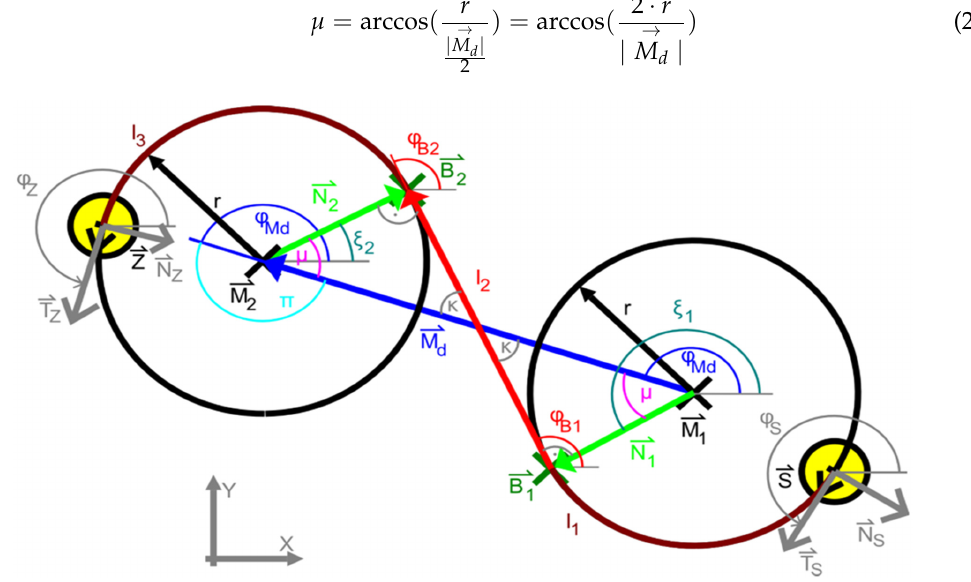
Figure 3. Circle trajectory with alternating flow direction (right- and left-handed).